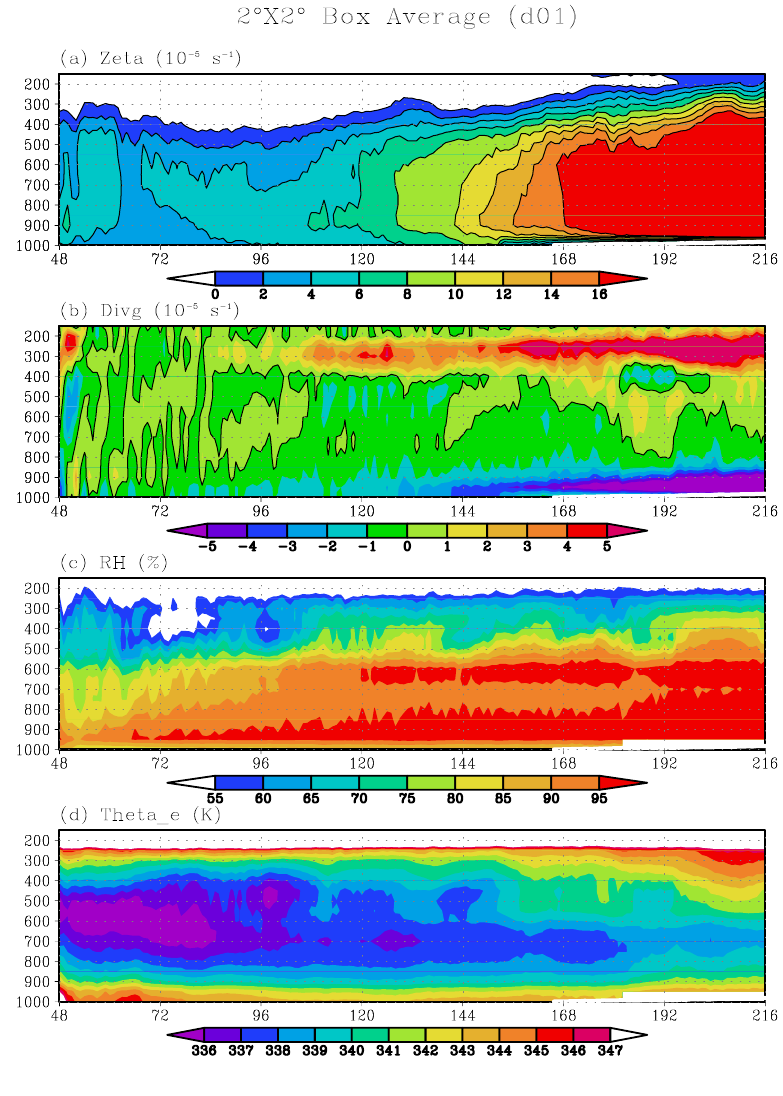
Fig. 18. Same as Fig. 16, except for the simulation with ice microphysics. See text for details.